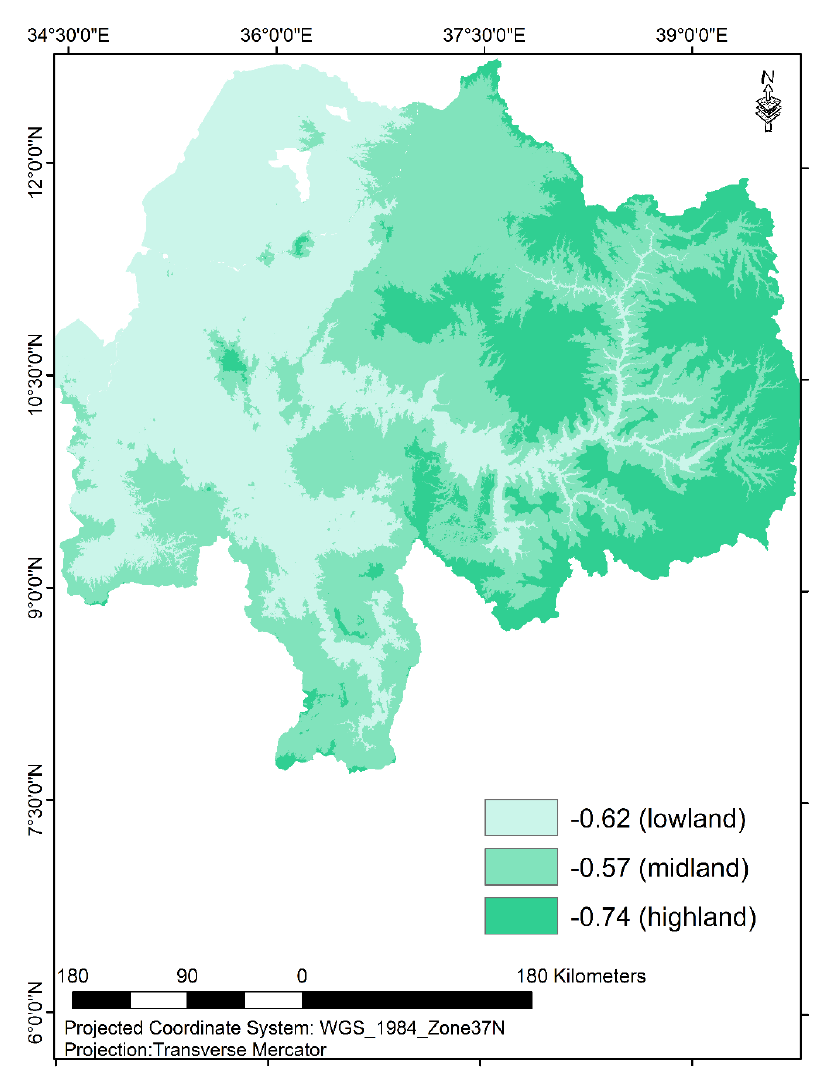
Figure 6. Mean SPI values (drought magnitude) from 2014–2017 in June and July over the elevation zones of the UBN.